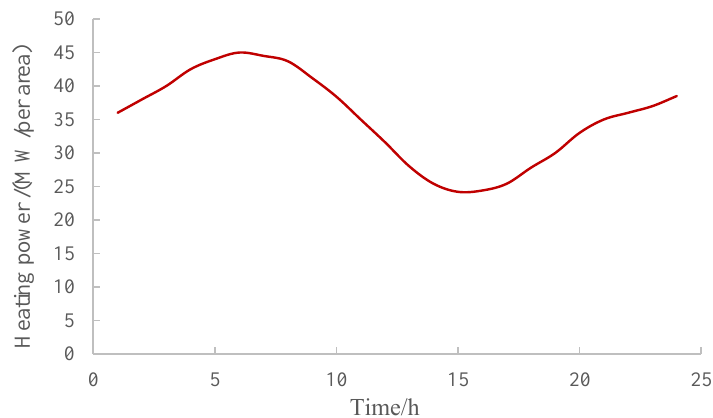
Figure 5. Typical daily heat load profile.